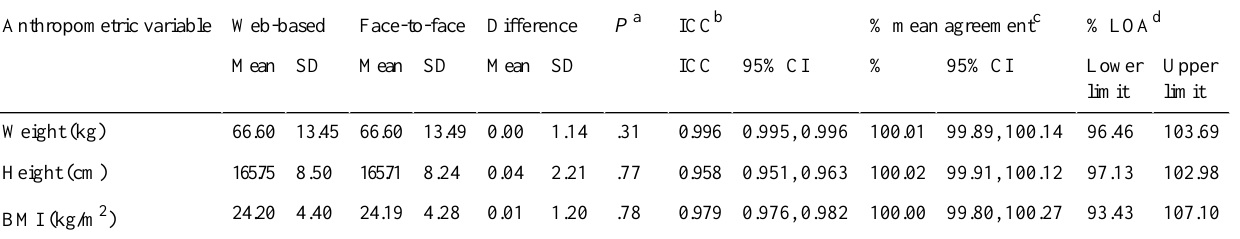
Table 4. Concordance indicators for continuous variables including intraclass correlation coefficient (ICC) between Web-based and face-to-face reported data, Bland–Altman mean agreement, and limits of agreement (LOA) from the NutriNet-Santé Study, 2012, France